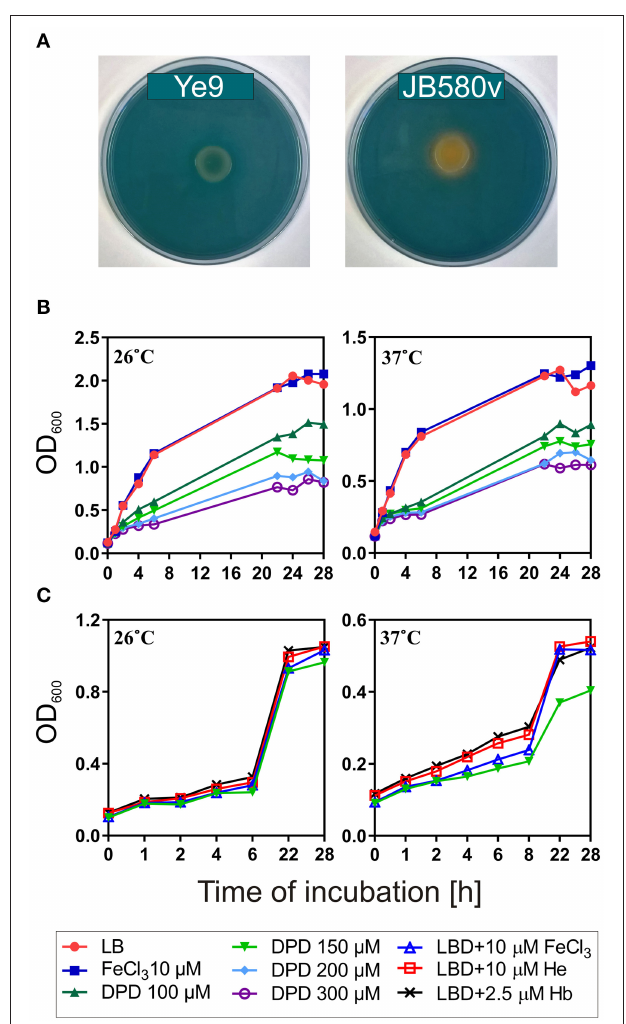
FIGURE 1 | Y. enterocolitica Ye9 siderophore production and heme-containing molecule utilization. (A) Siderophore activity was assessed using CAS agar plates. No color change is seen on the plate carrying growth of Ye9. In contrast, a change in color from blue to orange is observed when iron is removed from the iron-CAS complex by the siderophore yersiniabactin produced by JB580v cells. (B) The growth yield of Ye9 determined by measuring the OD 600 after 28-h incubation at 26 or 37 ◦ C in LB, LB with 10 µ M FeCl 3 , LB with 100, 150, 200, or 300 µ M 2,2 ′ -dipyridyl (DPD). (C) The growth yield of Ye9 in LBD medium (150 µ M DPD) containing hemin (He, 10 µ M) or hemoglobin (Hb, 2.5 µ M). The graphs present the results of one of two separate experiments performed in